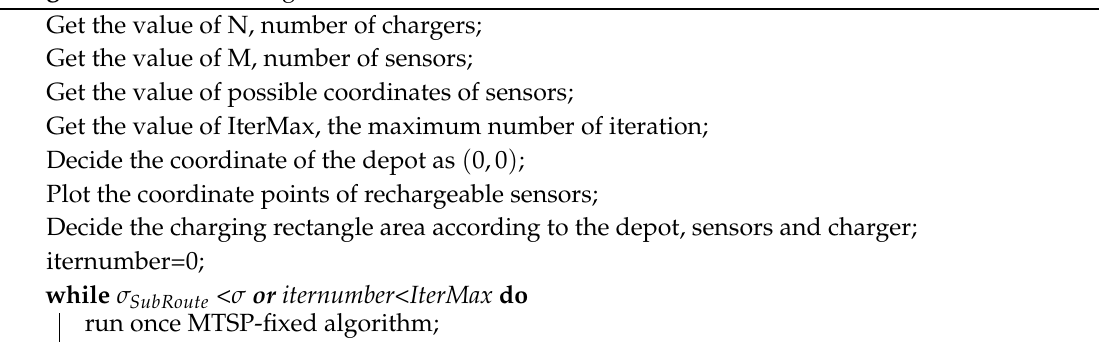
Algorithm 1: SCBMC algorithm based on